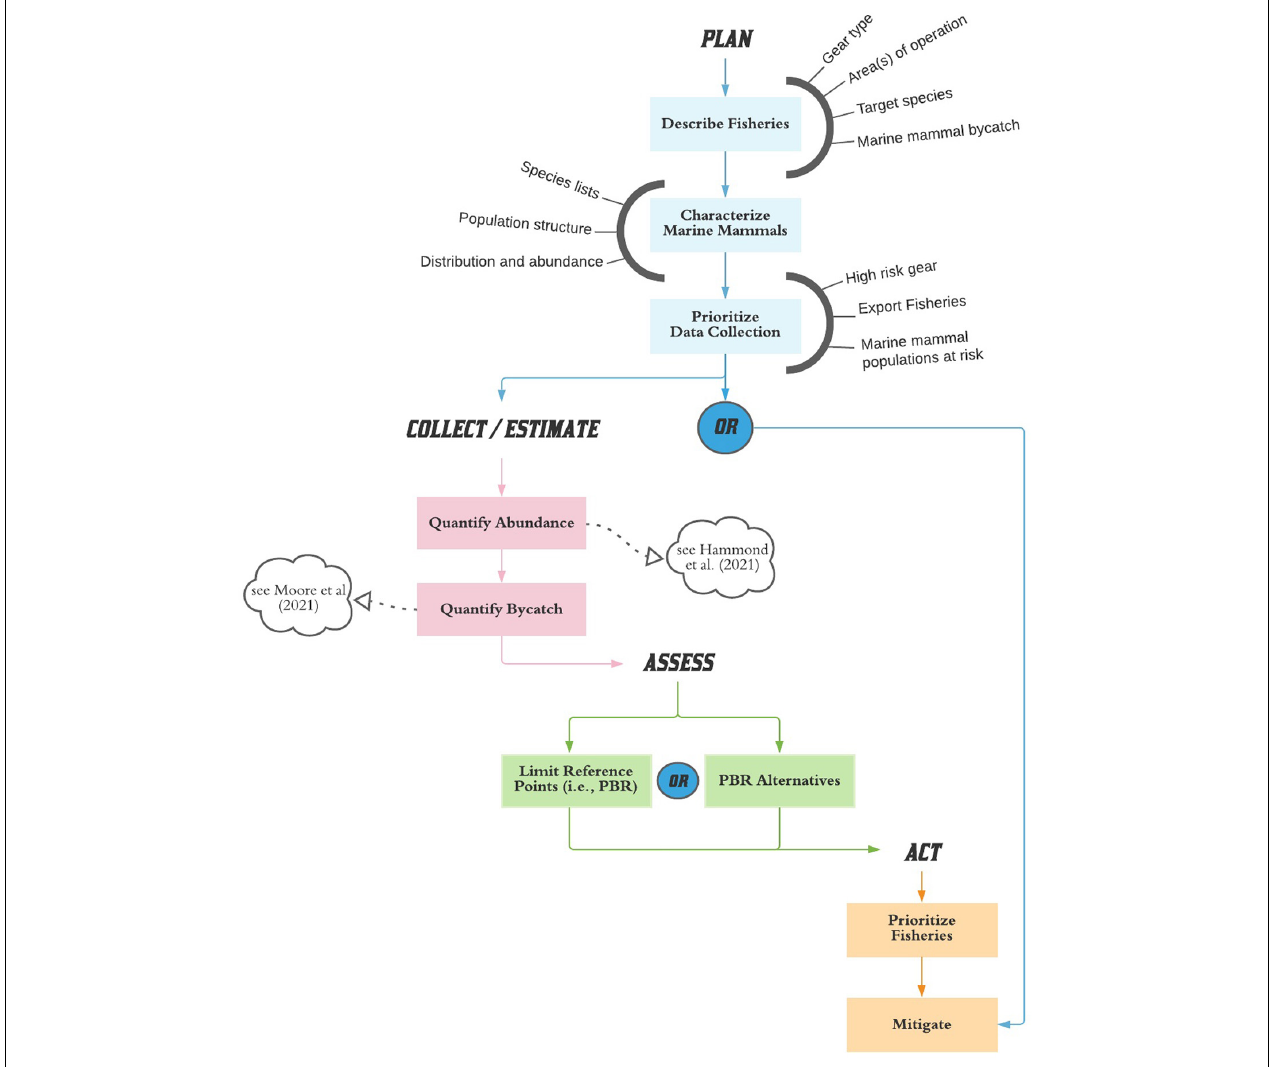
FIGURE 1 | A flow chart illustrating the process for assessing and managing bycatch of marine mammals. Names of flowchart components correspond to the names of the section headers in the